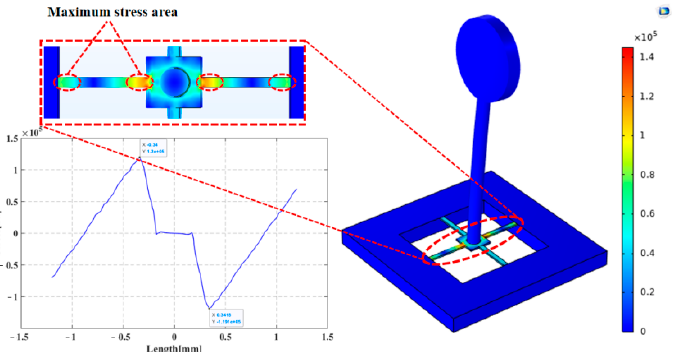
Figure 13. Centralized stress simulation of the cantilever beam micro-structure.